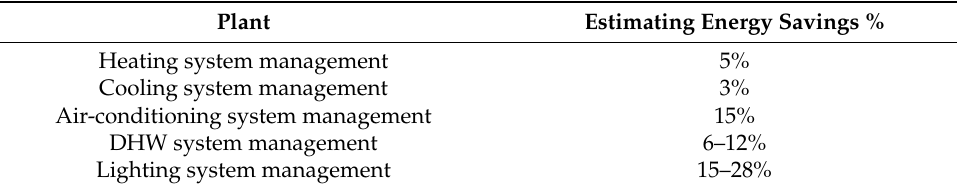
Table 2. Estimating energy savings with the application of home automation in residential buildings [31,33].